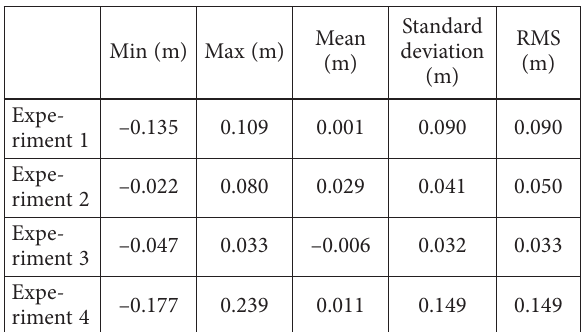
Table 4. Statistics of the results of the cross-validation